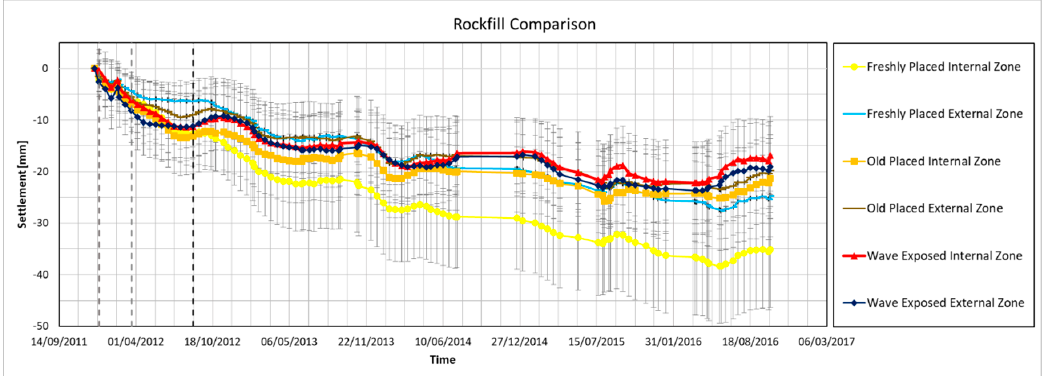
Figure 18 . Comparison of the In-SAR of the six studied subzones . Figure 18. Comparison of the In-SAR of the six studied